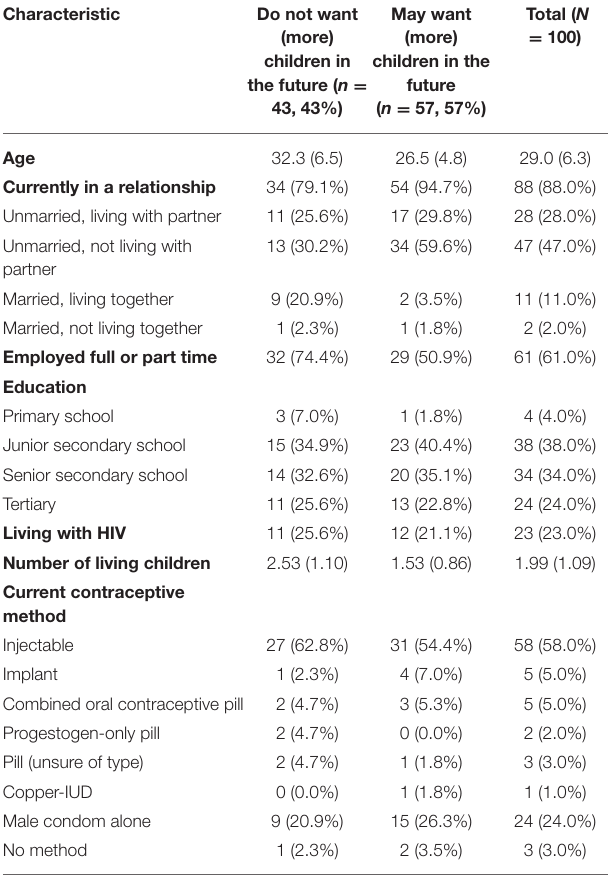
TABLE 2 | Characteristics of participants in a study assessing patient contraceptive preferences derived from attribute-based scoring using a Contraceptive Preference Assessment Tool and the degree of concordance between patient preferences for contraceptive methods and clinician recommendations in